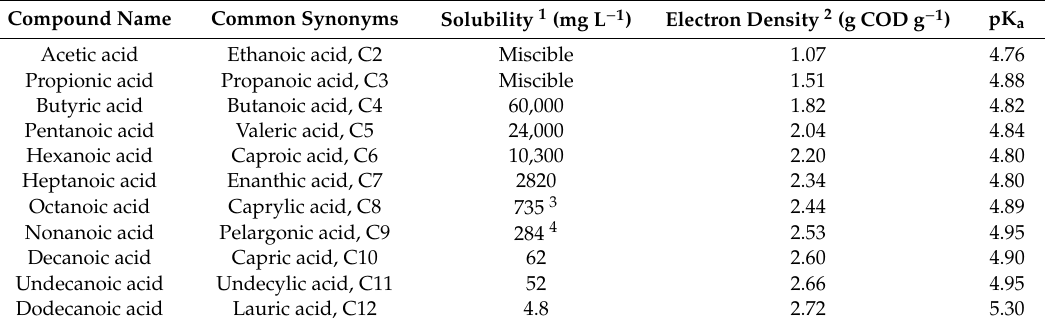
Table 1. Properties of short- and medium-chain fatty